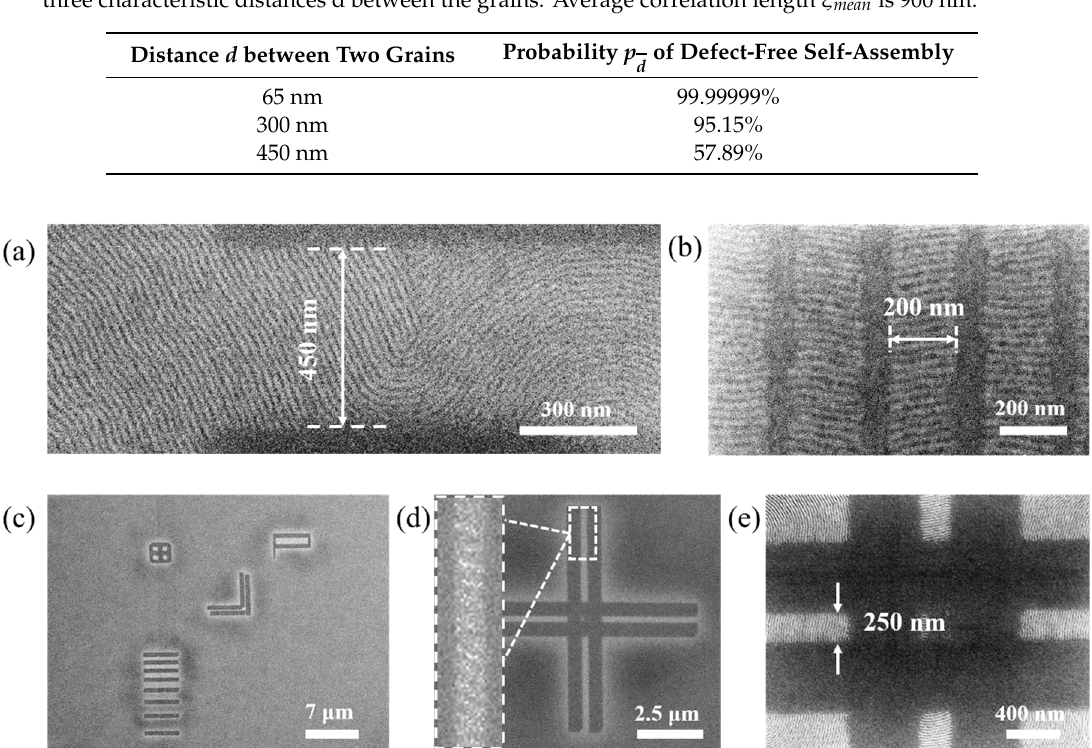
Figure 8. Alternative structures fabricated by grain-boundary-induced alignment. ( a ) Defective self-assembly due to a too large distance between the two grain boundaries; ( b ) self-assembly of multiple arrays of parallel lamella; ( c ) arbitrary shapes fabricated by mechanical AFM removal; ( d , e ) double-bar cross defined by mechanical AFM removal.